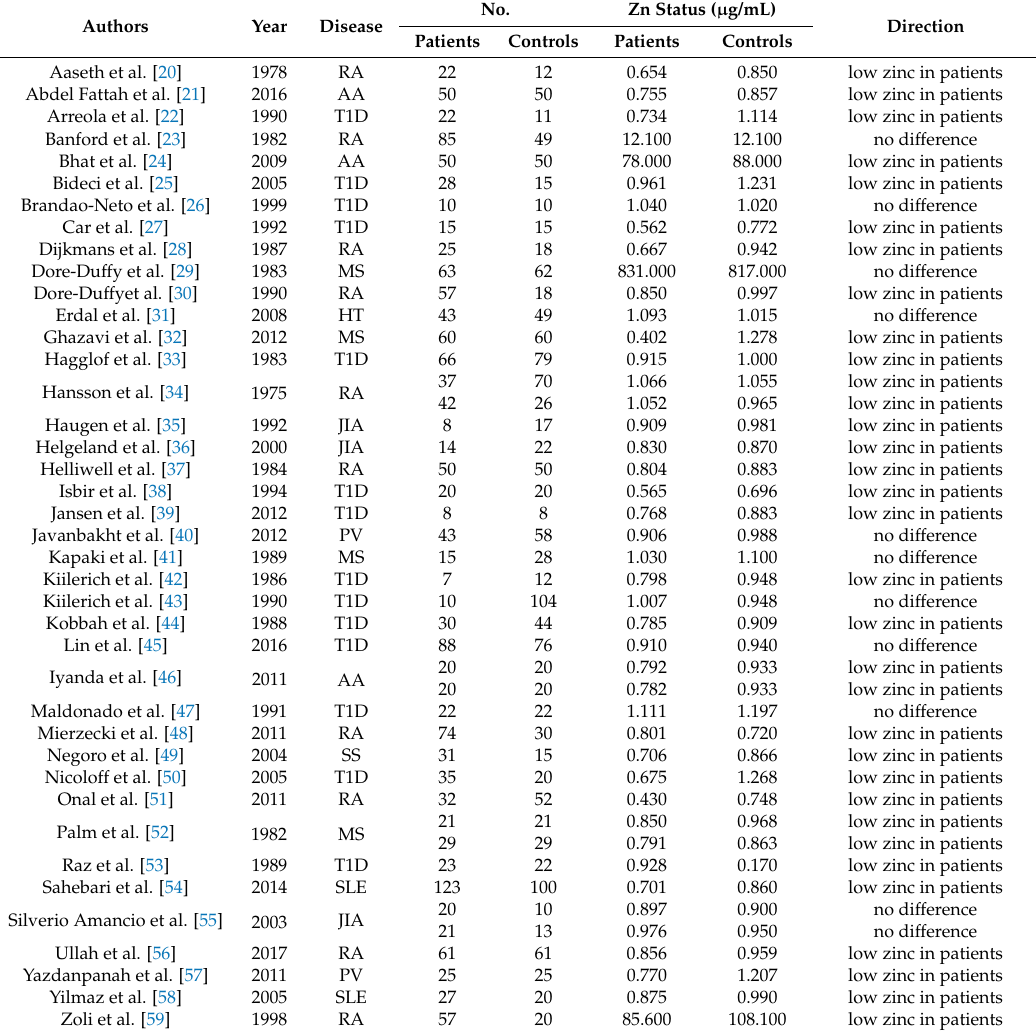
Table 1. Characteristics of selected studies included in meta-analysis in reference to serum samples.